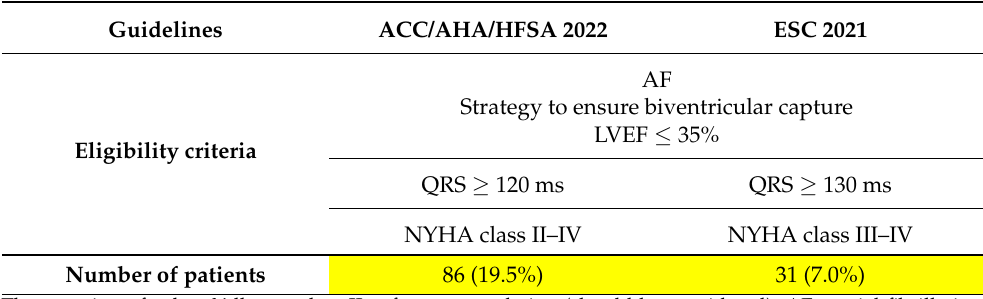
Table 4. Patients with heart failure and atrial fibrillation eligible for CRT based on the recent ACC/AHA/HFSA (2022) and ESC (2021)